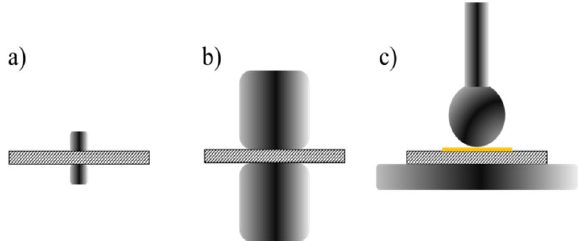
Fig. 1 Schematic drawings of electrode setups: (a) 6.4 mm cylinder electrodes on 50 mm sample, (b) 25 mm cylinder electrodes on 50 mm sample, (c) 50 mm sample with 25 mm thickfilm electrode and ball-on-sphere sample